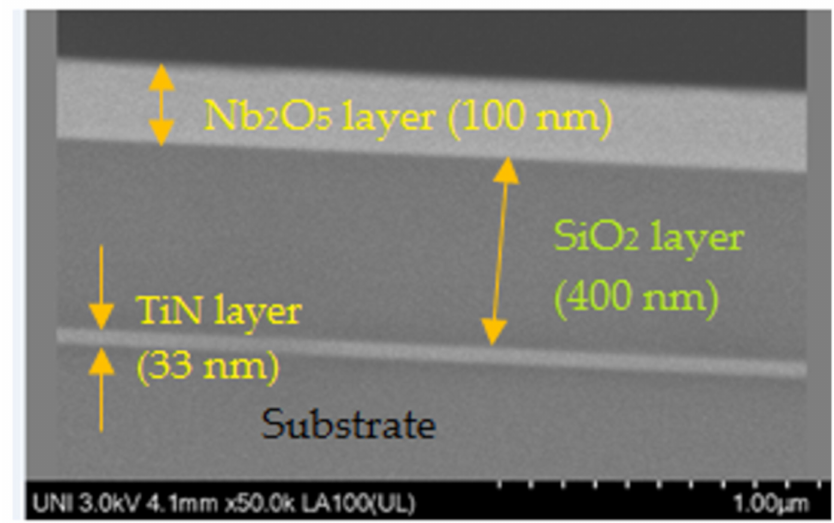
Figure 2. SEM micrography showing the cross-section of an Nb 2 O 5 / SiO 2 / TiN structure; the thicknesses were 33 nm for the TiN film, 400 nm for the SiO 2 layer and 100 nm for the Nb 2 O 5